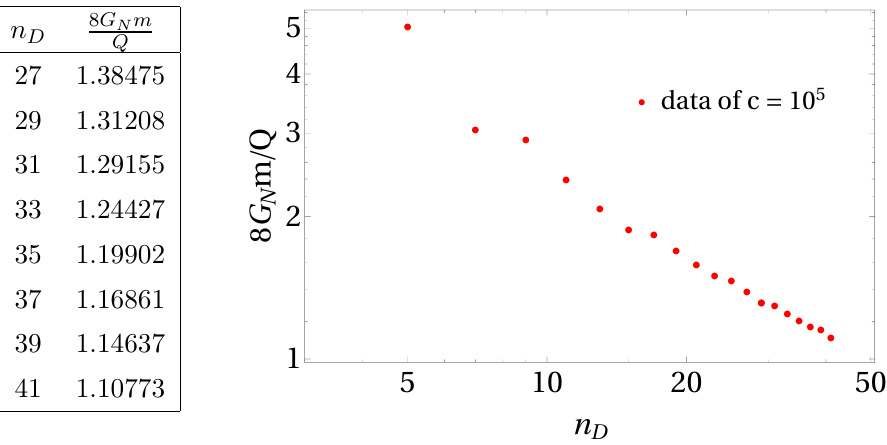
Figure 3 . Upper bound on 8 G N m (that is, there exists a state below the bound) as the number n D Q of derivatives used in the semide(cid:12)nite programming analysis increases, for the speci(cid:12)c case c = 10 5 . The bound value is still changing rapidly at n D =